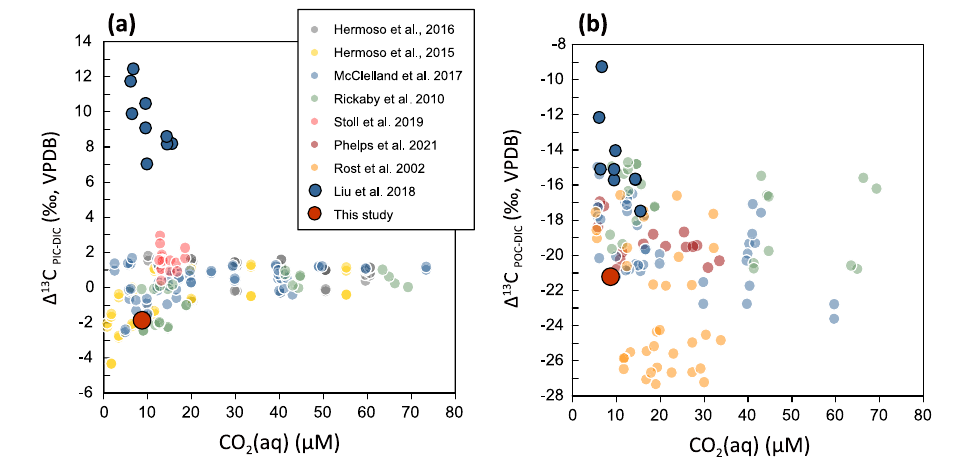
Fig. 1 | Carbon isotope fractionations ( Δ 13 C) of coccolithophores in different laboratory culture studies. a Carbon isotope fractionation between PIC (parti- culate inorganic carbon from harvested cells) and DIC (dissolved inorganic carbon from seawater). b Carbon isotope fractionation between POC (particulate organic carbon from harvested cells) and DIC. Markers plotted in red and blue are